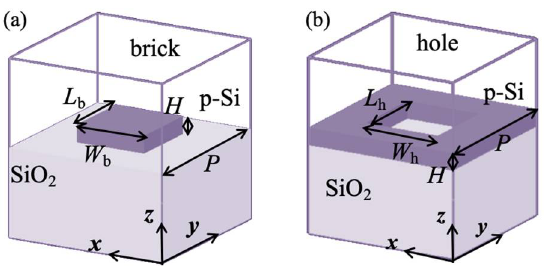
Figure 1. Schematics of two unit-cells: ( a ) Nanobricks; ( b ) Nanoholes. The nanostructures have the same parameters as height H = 200 nm and lattice period P = 600 nm. The rectangular shapes are described by length L b and L h , and width W b and W h, respectively.